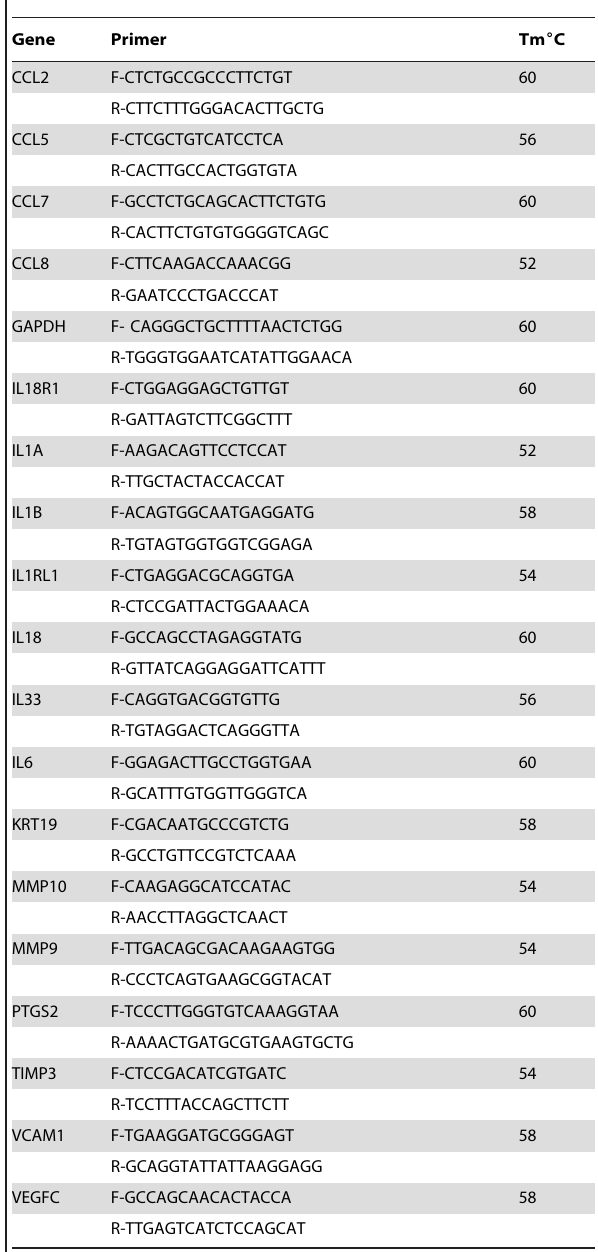
Table 1. List of PCR